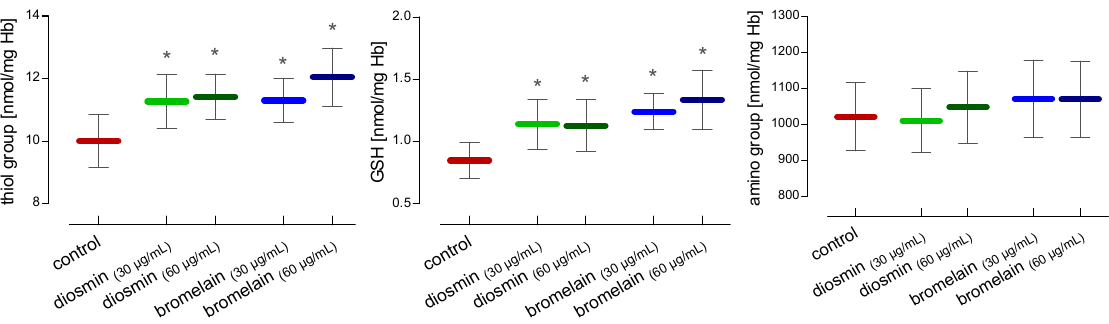
Figure 3. Alterations in thiol and amino groups and glutathione concentrations in RBCs after 24 h of incubation with diosmin or bromelain. Data were expressed as mean ± standard deviation, n = 16. Statistical significance: * p < 0.05 vs. control.